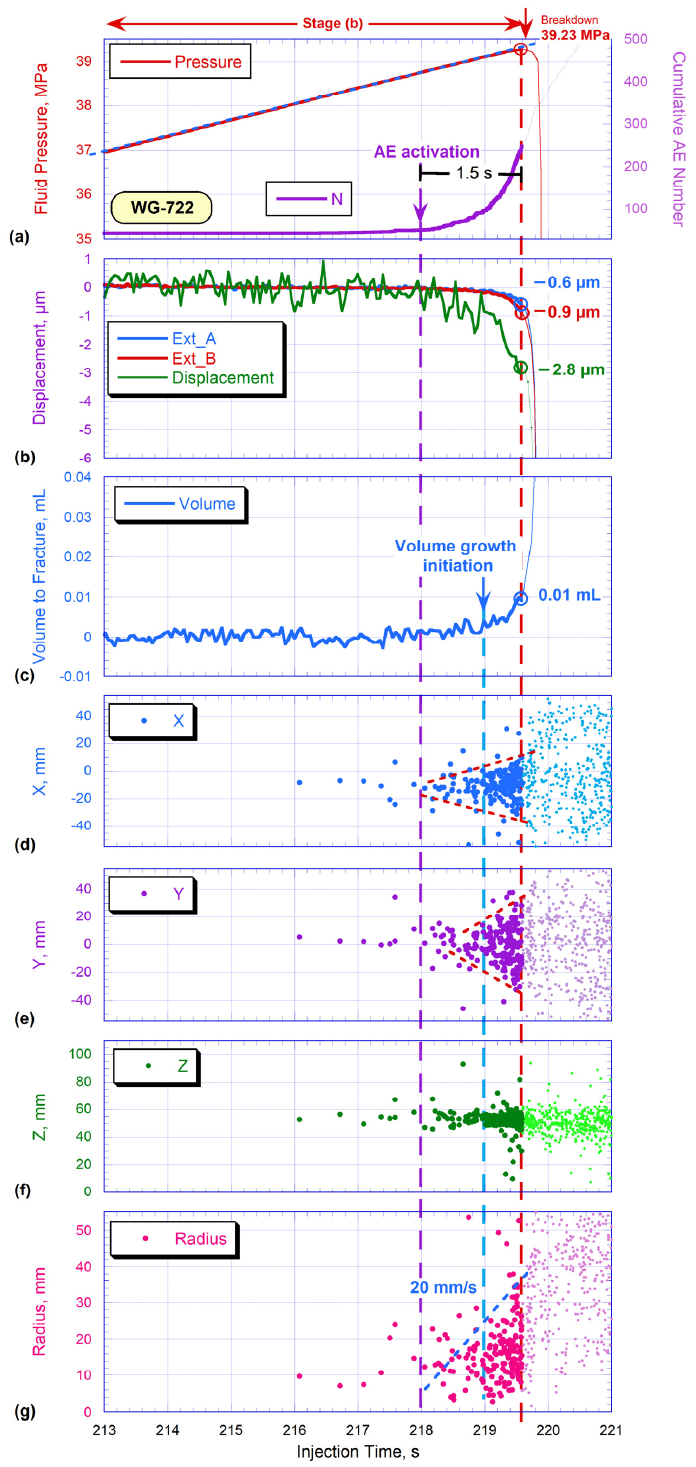
Figure 16. Sample WG-722: ( a ) fluid pressure (red) and the total number of AE signals located (pur- ple); ( b ) axial deformations measured by the left (Ext_B, red) and right (Ext_A, blue) extensometers and a curve demonstrating piston position (green); ( c ) the volume of fluid injected into the hydraulic fracture; ( d , e ) horizontal coordinates of the located AE signals in the X and Y directions, respectively; ( f ) vertical coordinates of the located AE signals; ( g ) distribution of the distances between located AE signals and the axis of the sample. All parameters are plotted versus the time of sample